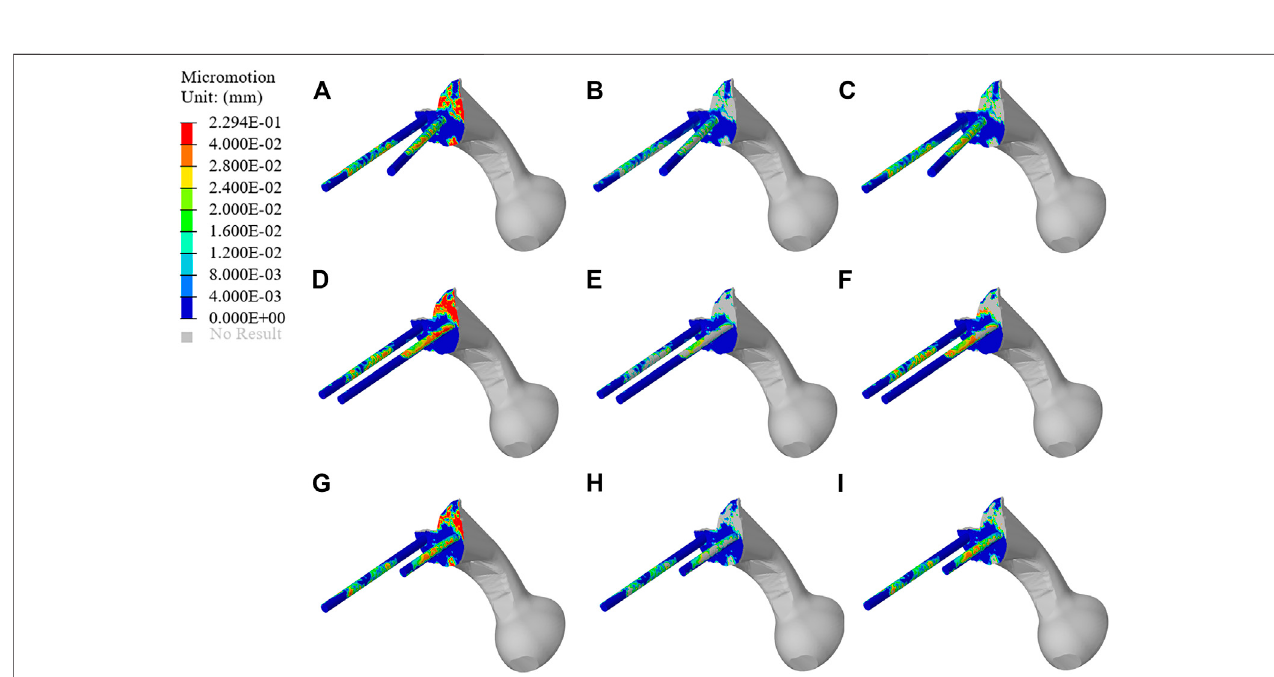
FIGURE 9 | Micromotion results of original prosthesis. (A – C) represent the micromotion distribution of BMD screws, (D – F) represent the micromotion distribution oflongscrews,and (G – I) represent themicromotiondistribution ofshortscrews.Thecoloredpartsof (B,E,H) representtheareawithmicromotionlessthan28 μ m,and the colored parts of (C,F,I) represent the area with micromotion less than 40 μ m.